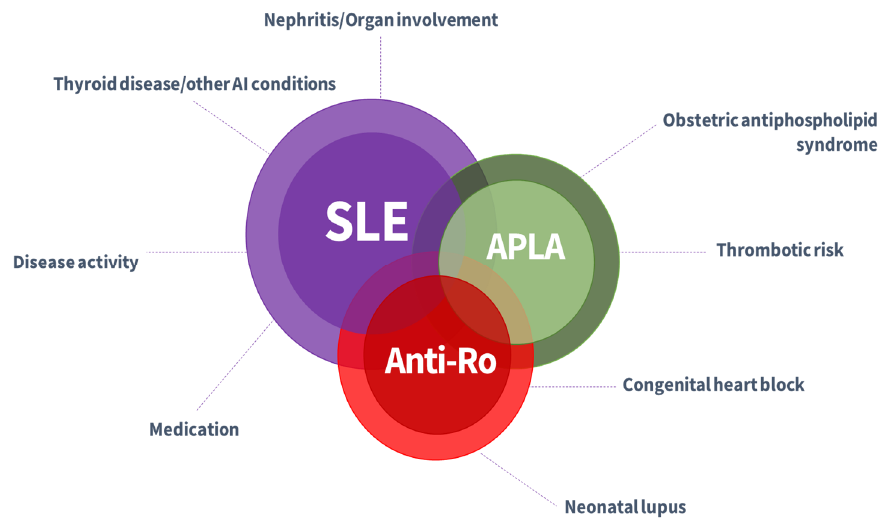
Figure 1. Pre-pregnancy aspects relevant for patients with known systemic lupus erythematosus.